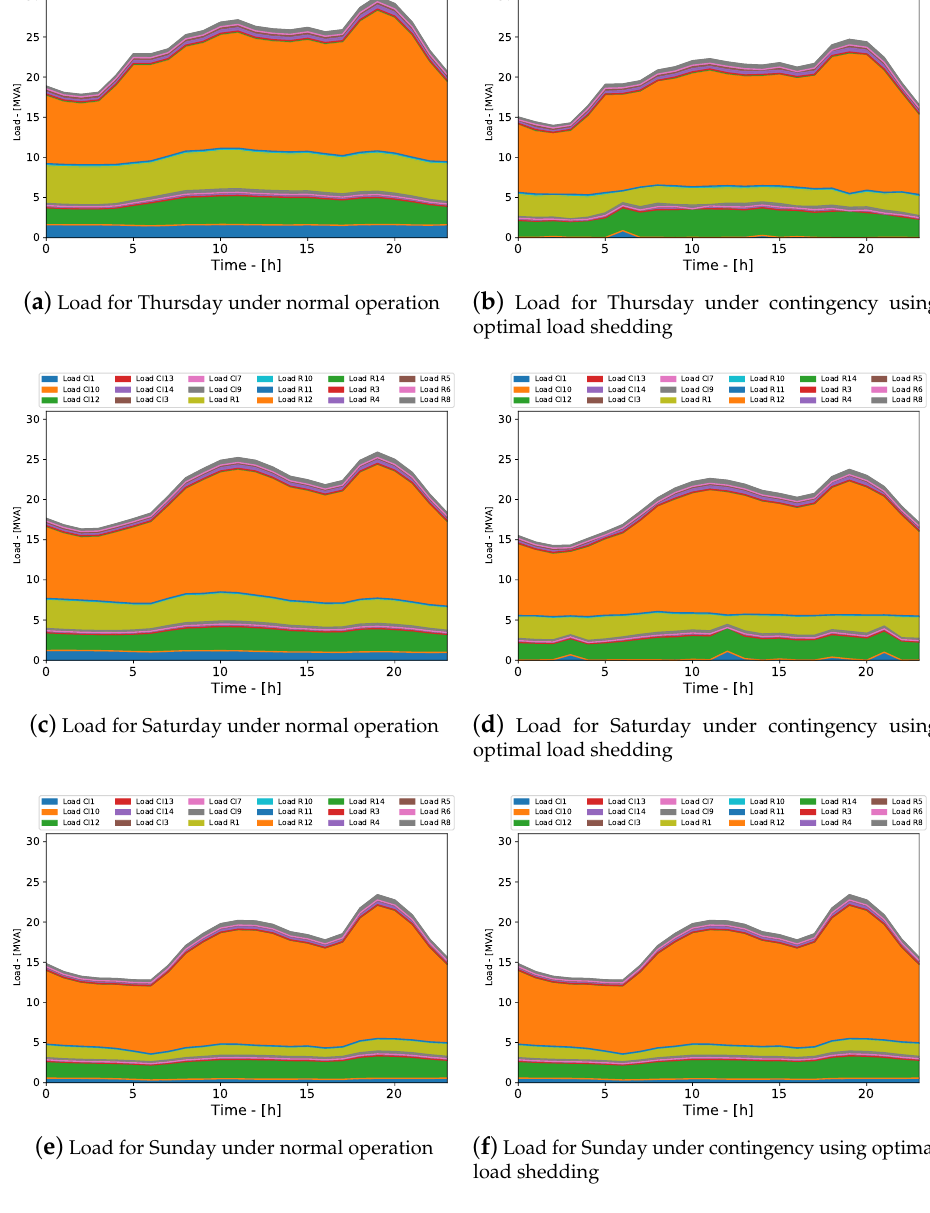
Figure 5. Load considering both normal operation and load shedding using the proposed methodology, when Trafo 0-1 is out of